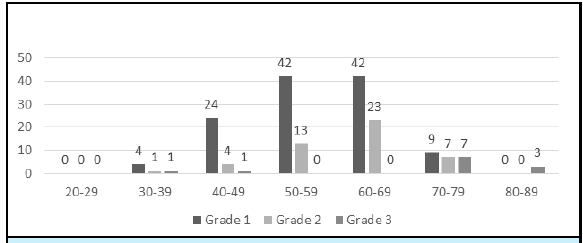
Figure 2. Bar diagram of the distribution of grades of BAC according to age group.